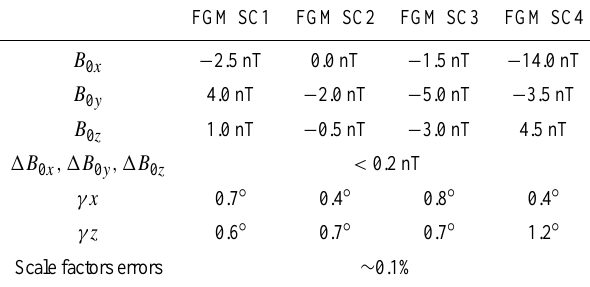
Table 4. Calibration summary for the outboard sensor